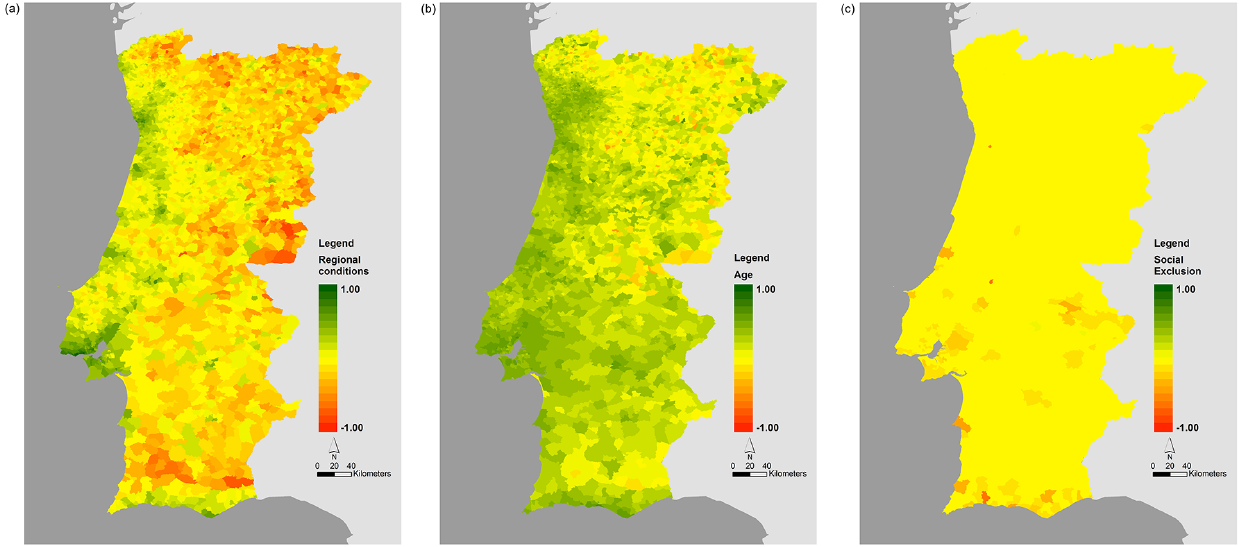
Figure 2. Maps of the three flood social susceptibility indicators for the continental Portuguese territory: (a) regional conditions, (b) age, and (c) social exclusion.